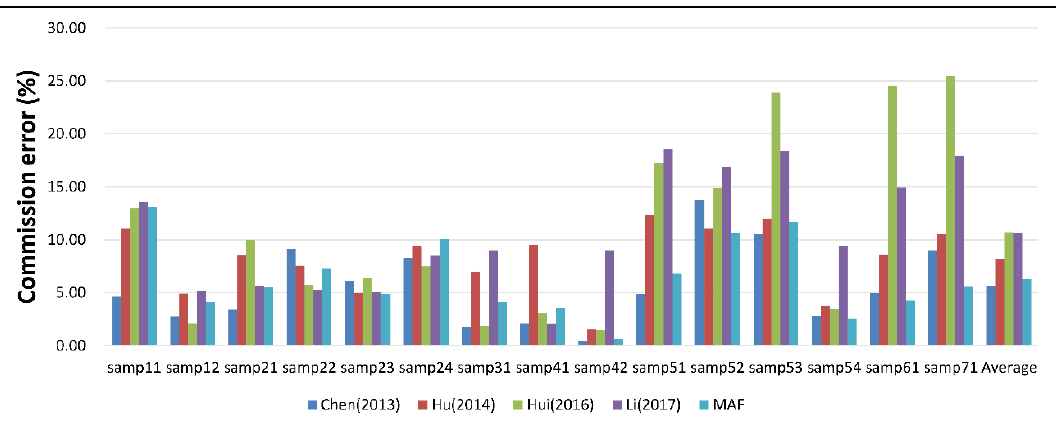
Figure 5. Comparison of commission errors for filtering ISPRS samples.